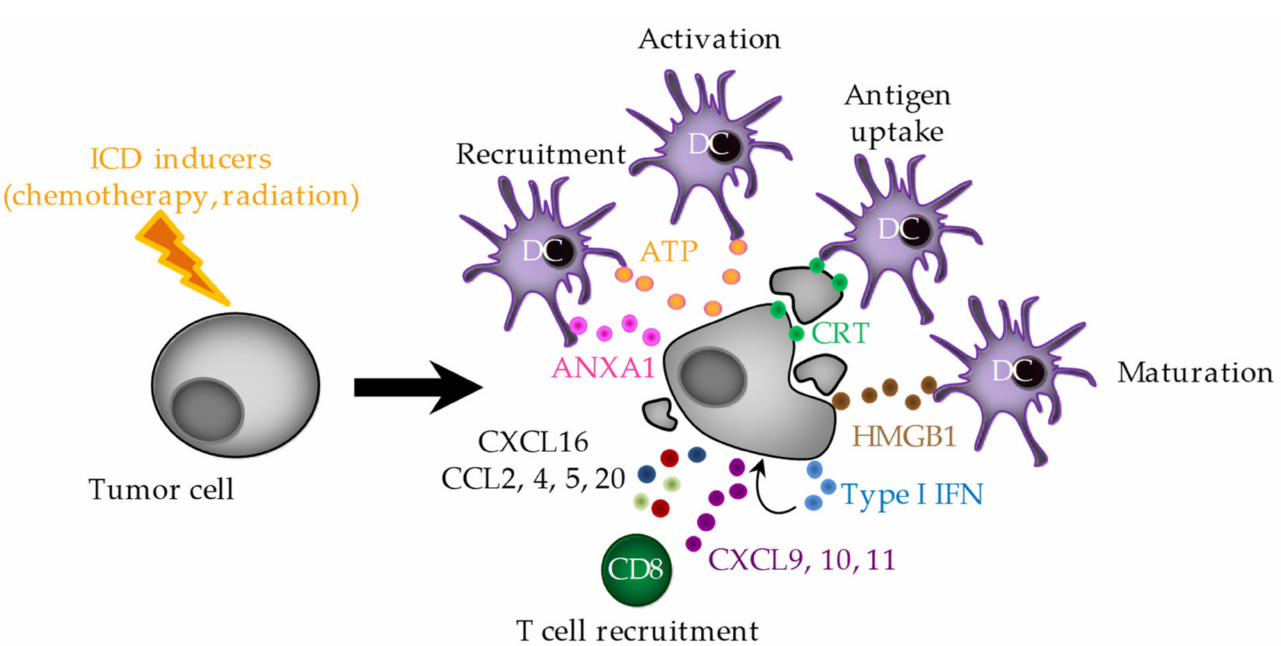
Figure 1. Immunogenic cell death (ICD) features. ICD is characterized by ER stress and calreticulin (CRT) exposure, ATP, HMGB1 (High-Mobility Group Box 1), ANXA1 (annexin A1) and type I interferon (IFN) production by dying cancer cells, thus leading to DC recruitment, maturation and activation. ICD is also characterized by chemokine production (mediated in some circumstances by type I IFN) which in turn triggers CD8 T-cell recruitment at the tumor